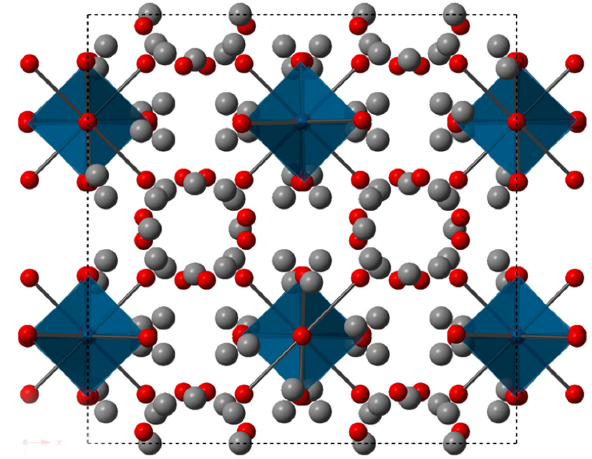
Figure 1. A view of the structure of Yb 14 ZnSb 11 down the c axis. Yb atoms are grey, Sb atoms are in red, and the blue tetrahedra are the ZnSb 4 units.